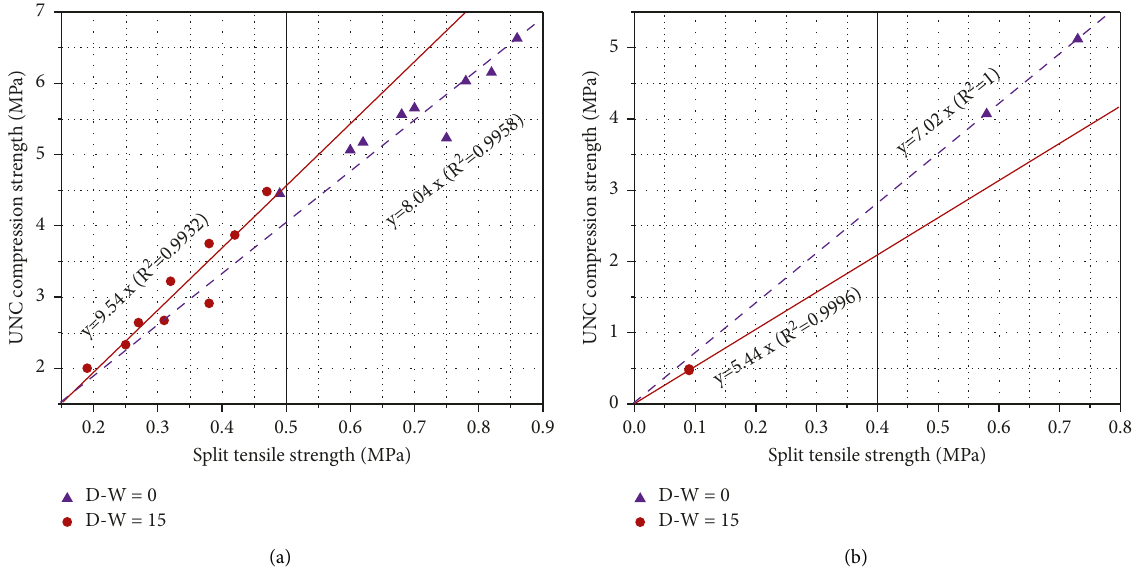
Figure 10: Relationship between the compressive and tensile strengths of the L-MK- and NHL-modified soil. (a) L-MK. (b) NHL.